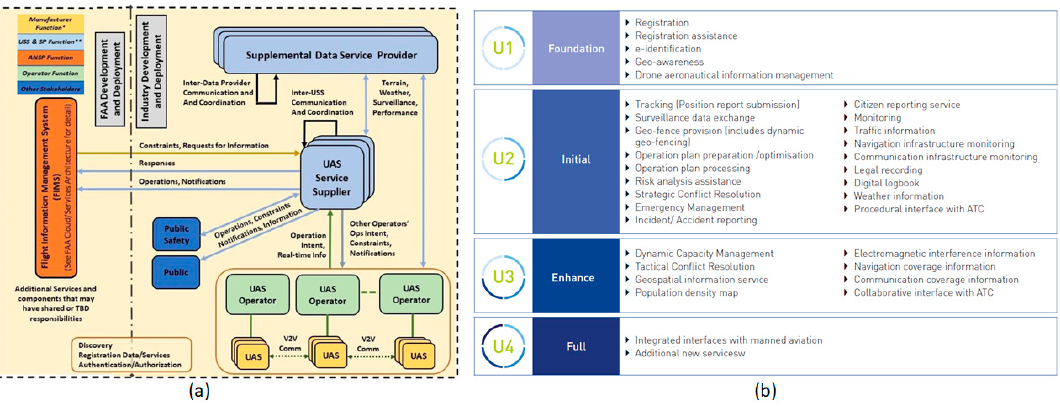
Figure 1. ( a ) Schematic of USA’s UTM architecture [17]; ( b ) Europe’s U-Space Services [30].